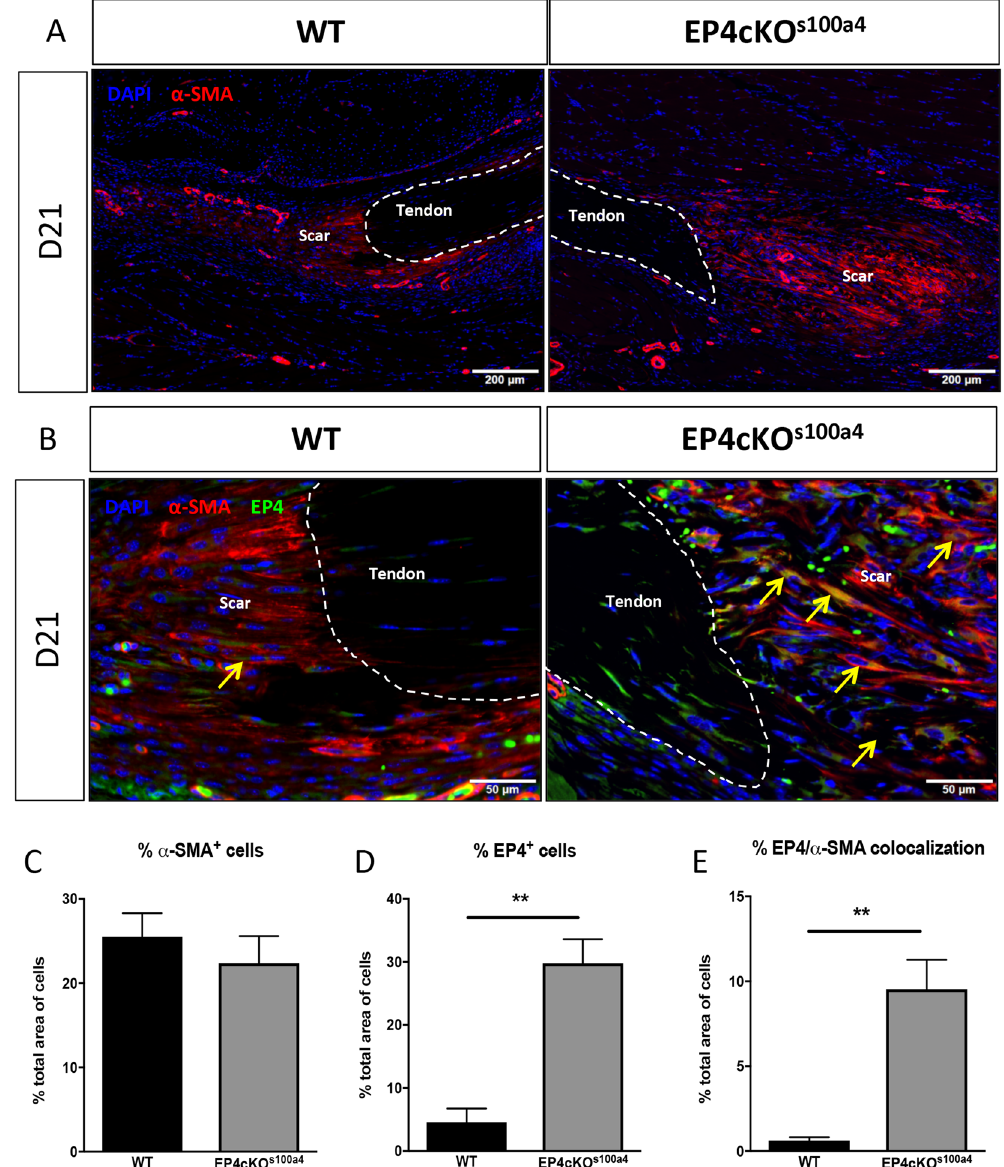
Figure 7. EP4-expressing α -SMA myofibroblasts are increased in EP4cKO S100a4 repairs during later healing. ( A ) Abundant expression of α -SMA + was observed in EP4cKO S100a4 and WT repairs on day 21 post- surgery. α -SMA + cells are identified by red fluorescent staining, while nuclear stain DAPI is blue. Scale bars represent 200 microns. ( B ) Co-immunofluorescence for α -SMA (red) and EP4 (green) demonstrate very few α -SMA + , EP4 + cells (yellow arrow) in WT repairs at day 21. In contrast, abundant α -SMA + , EP4 + cells (yellow arrows) are observed in EP4cKO S100a4 repairs at this time. Scale bars represent 50 microns. ( D – F ) Quantitative assessment of ( D ) α -SMA + cells, ( E ) EP4 + cells, and (F) α -SMA, EP4 double positive cells by immunofluorescence at day 21. ( ** ) Indicates p < 0.01 between WT and EP4cKO S100a4